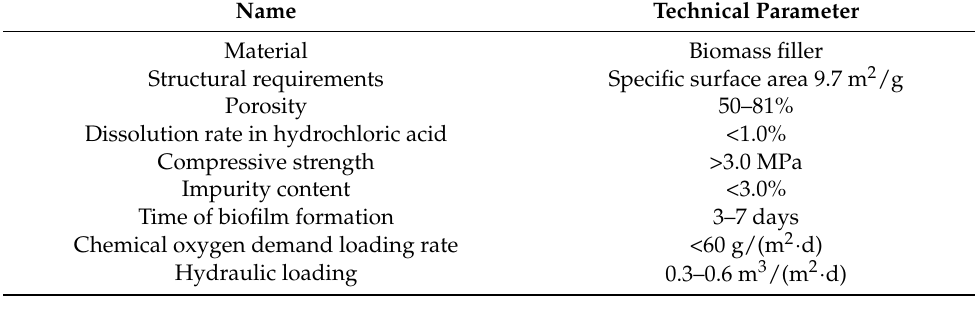
Figure 2. Dimensions of the artificial reef.